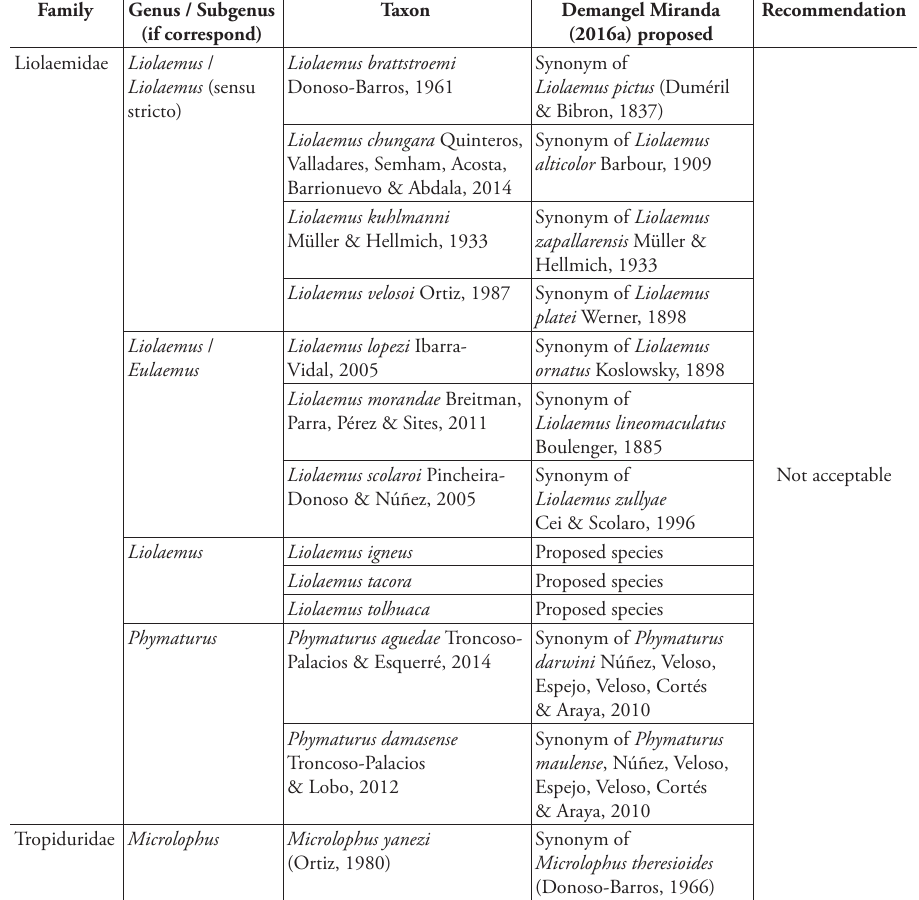
Table 1. Summary of the taxonomic changes proposed by Demangel Miranda (2016a). Details of recom- mendation are explained in the text. Liolaemus subgenera are according to Abdala and Quinteros (2014).